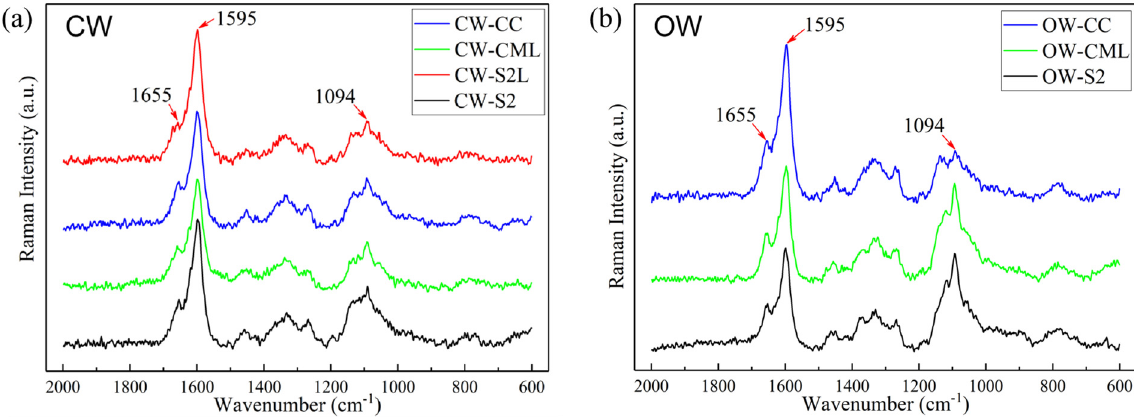
Figure 10. Transverse Raman absorption spectra in cross-section of CW ( a ) and OW ( b ). Bands at 1094 cm –1 were due to cellulose. Bands at 1595 cm –1 and 1655 cm –1 were due to lignin. (CML: compound middle lamella)